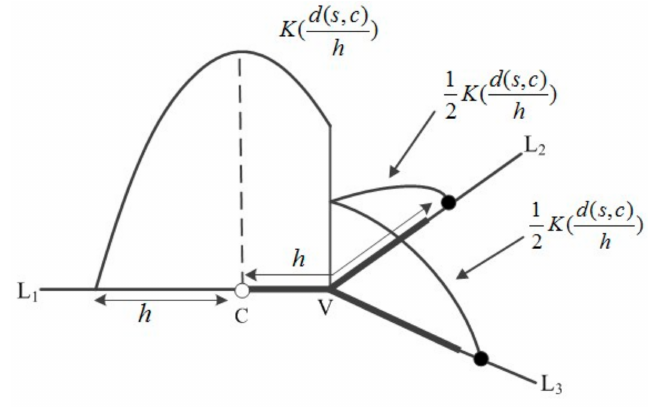
Figure 9. The network kernel density function at